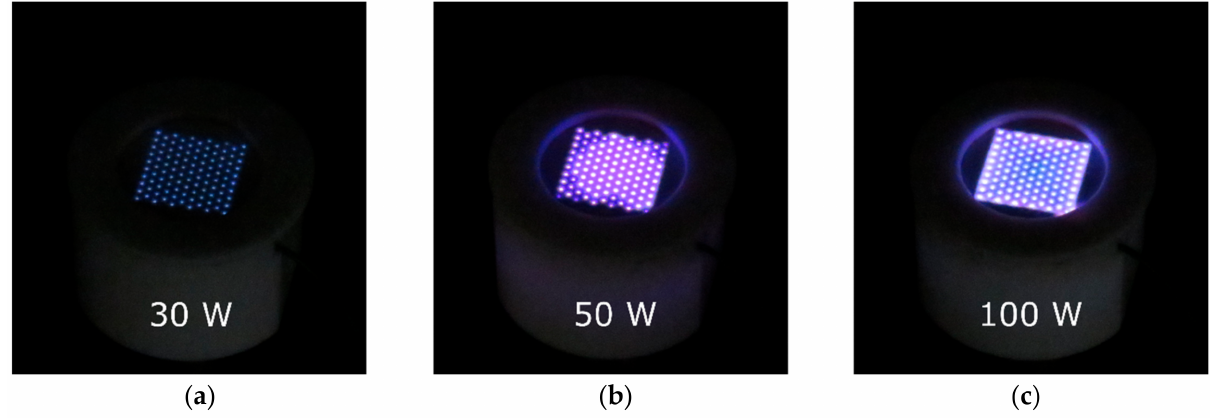
Figure 1. The photographs of multi-hollow surface dielectric barrier discharge (MSDBD) at the stabilized flow of pure water vapor at different input power ( a – c ).